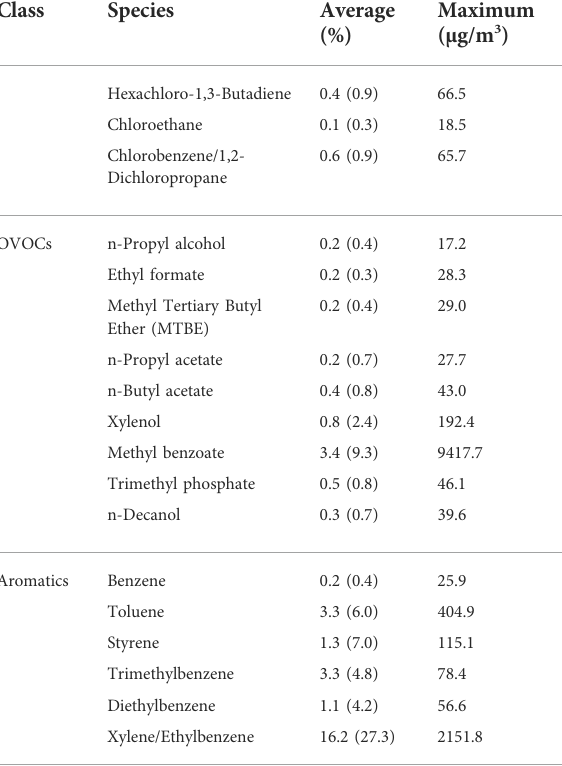
TABLE 2 ( Continued ) Summary of VOCs concentration from cruise monitoring in Jilin